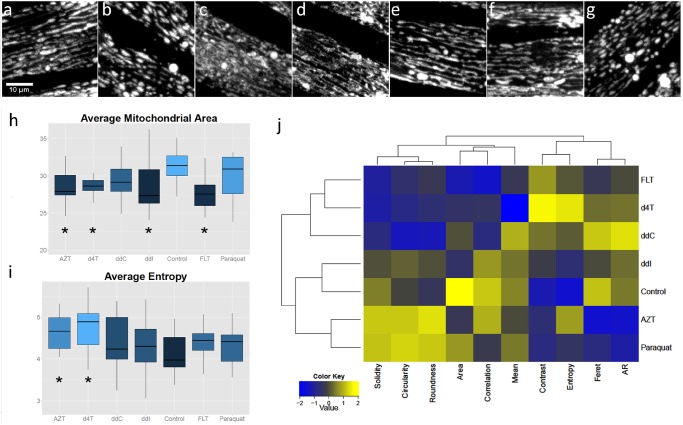
Exposure to NRTIs causes changes in mitochondrial morphology.a-g: Mitochondrial morphology in the body wall muscle of worms exposed to NRTIs (200 μM) (a: control, b: AZT, c: FLT, d: d4T, e: ddI, f: ddC) and g: Paraquat.) (h,i): Boxplots comparing selected metrics per condition. Asterisks indicate statistically different from control (per metric). (j): Two-dimensional clustergram performed on the standardized dataset (z-scores) of features extracted after image analysis, using Euclidean distance as distance metric and the average value as linkage value for the dendrograms